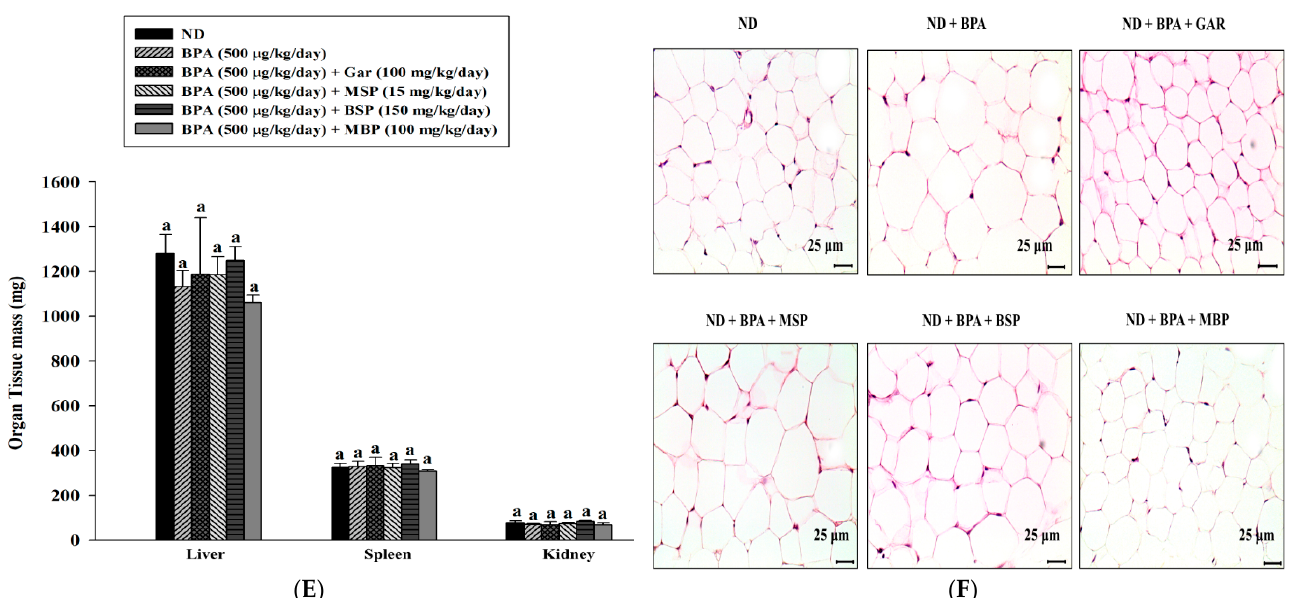
Figure 4. Effects of MBP, BSP, and MSP on adipose tissue structure, tissue weight, and body weight in C57BL/6J mice with BPA-induced obesity. Epididymal adipose tissue sections were stained with H&E and observed under a microscope at 400× magnification. Changes in total body weight ( A ). Body weight gain over 12 weeks ( B ). Food intake ( C ). Epididymal adipose tissue weight ( D ). Other tissue weight ( E ). Histology of the epididymal adipose tissue ( F ). Each value is expressed as mean ± SD ( n = 5). Different lower letters on the bars indicate statistical differences at p < 0.05.